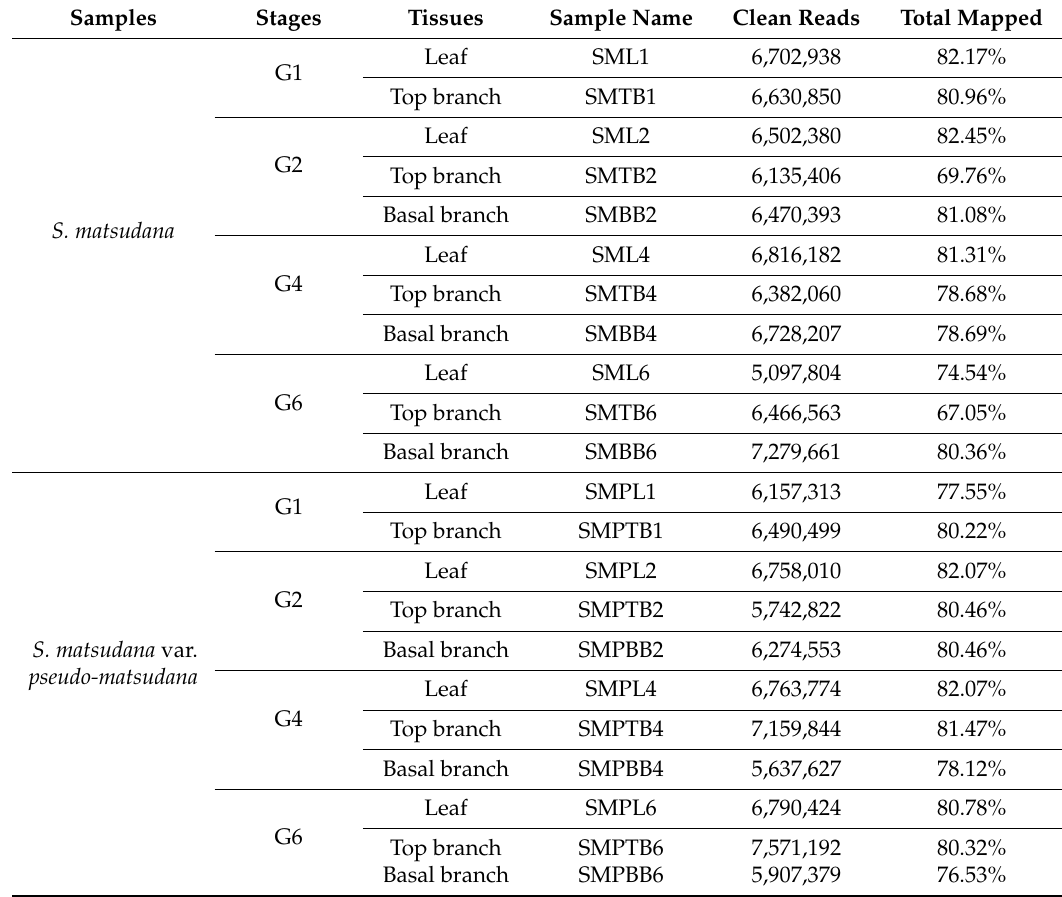
Table 1. Summary of the DGE sequencing and assembly